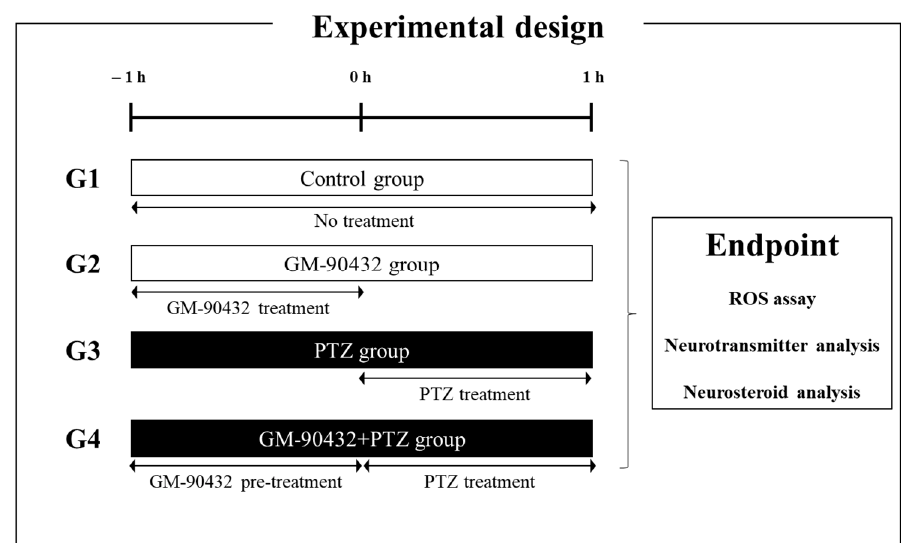
Figure 1. Experimental scheme used to determine the protective effect of GM-90432 against PTZ-induced epileptic seizures in zebrafish larvae and adults. Zebrafish were separated into 4 different treatment groups (G): G1: control group, G2: GM–90432 group, G3: PTZ-induced epilepsy model group, and G4: GM-90432 + PTZ group. At the experimental endpoint, zebrafish were sacrificed for analysis of ROS levels (larva only), and neurotransmitter and neurosteroid analyses.